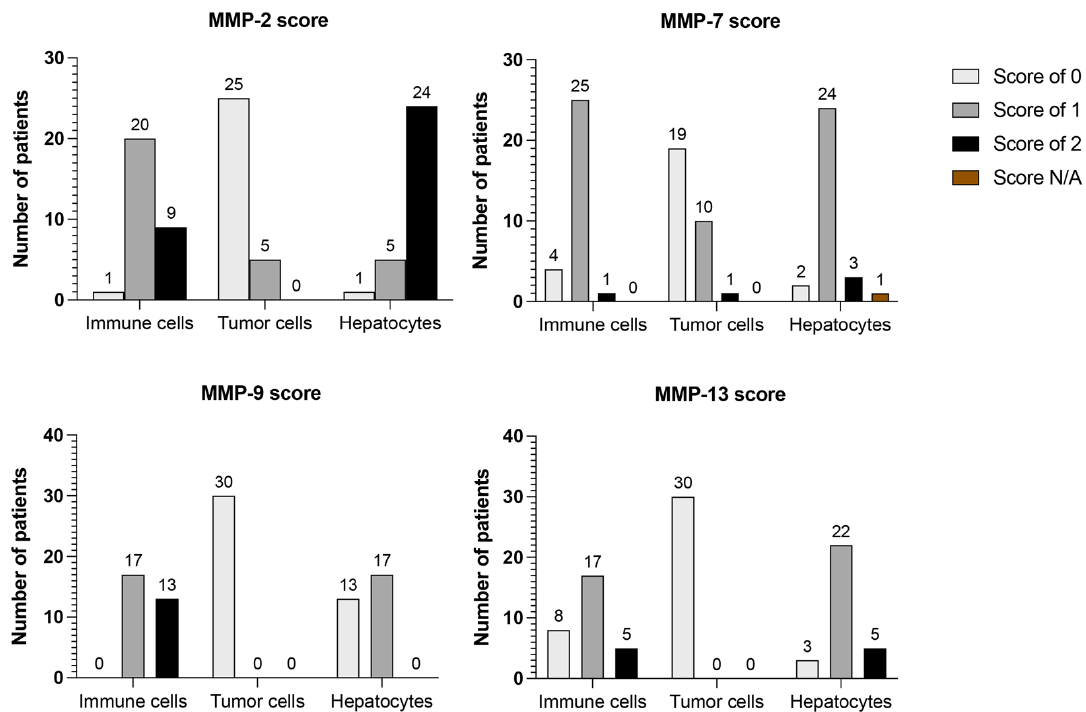
Figure 4. Box plots of matrix metalloproteinases (MMP) scoring in colorectal liver metastases (CLM) ( n = 30). The analysis shows that MMP-2, -7, -9, and -13 are mainly expressed in hepatocytes and immune cells. MMP-2 scoring was based on the intensity of cytoplasmic granular staining in hepatocytes and tumor cells, as follows: 0, no positivity in any cell; 1, mild staining in some to many cells or strong staining in a few cells; 2, moderate to strong staining in many cells. The scoring of stromal cells was based on the amount of stained immune cells, as follows: 0, no positivity in any cell; 1, a few to some stained immune cells; 2, many stained immune cells. MMP-7, -9, and -13 scoring were based on the intensity of cytoplasmic granular staining in hepatocytes and tumor cells, as follows: 0, no positivity in any cell; 1, staining in some cells; 2, staining in many cells. The scoring of stromal cells was based on the amount of stained immune cells, as follows: 0, no positivity in any cell; 1, some stained immune cells; 2, many stained immune cells.